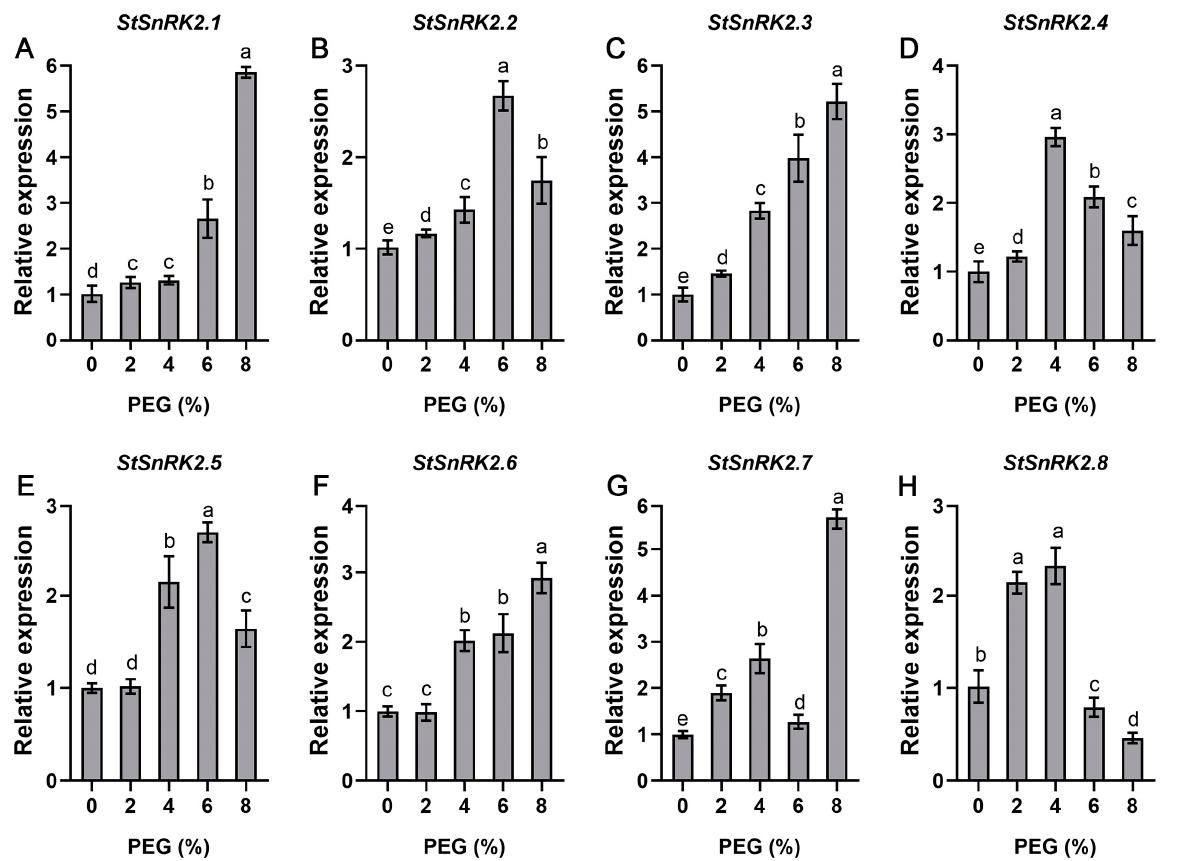
Figure 9. Relative expression level of StSnRK2 genes under different concentrations of PEG stress treatments. Data represent the means ± SD of three replicates, and different letters indicate significant differences at p < 0.05. ( A – H ) StSnRK2.1 – StSnRK2.8 , respectively.